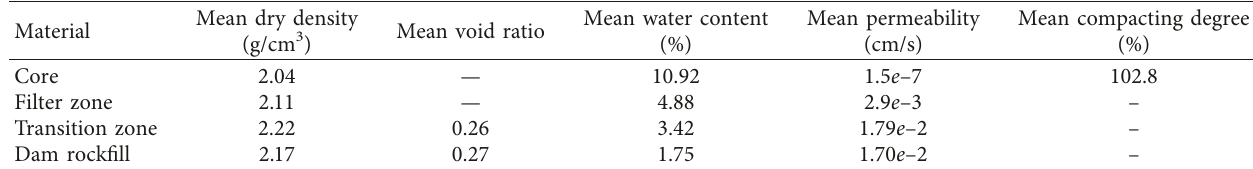
Figure 4: Grain size distributions of the dam materials in the Maoergai and Qiaoqi dams. Table 2: Physical properties of the materials in the Maoergai